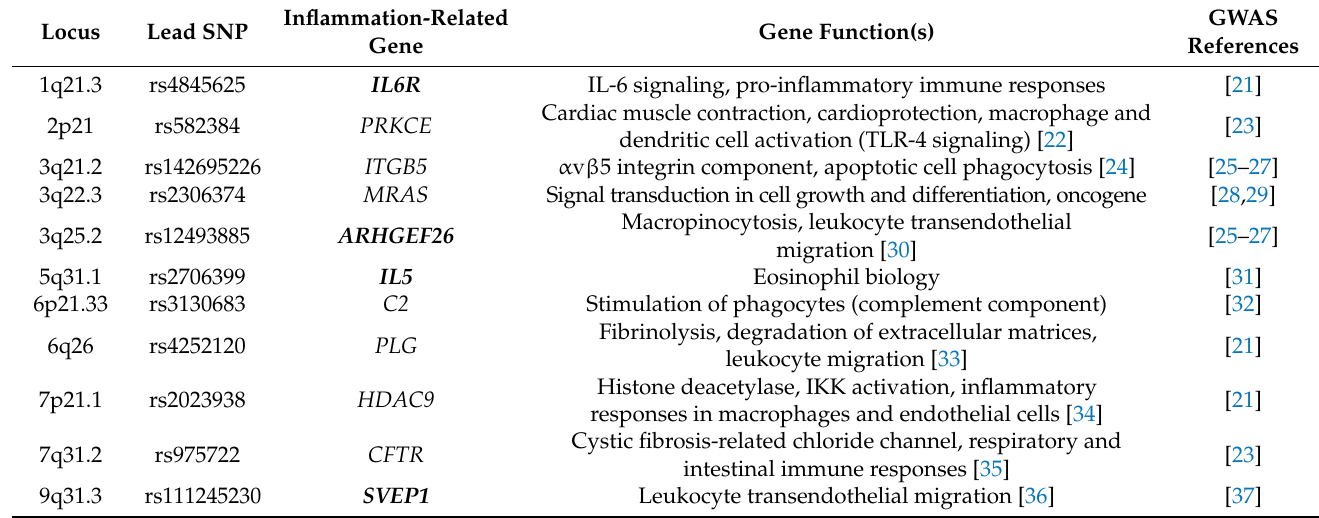
Table 1. Genome- and exome-wide significant risk loci associated with coronary artery disease in genes primarily related to inflammatory processes (modified from Erdmann et al. (2018) [10]. Loci that have received more extensive experimental research regarding their functional involvement in coronary artery disease (CAD) are marked in bold. GWAS: Genome-Wide Association Study, IKK: I κ B Kinase, IL: Interleukin, TLR-4: Toll-Like-Receptor 4, SNP: single nucleotide